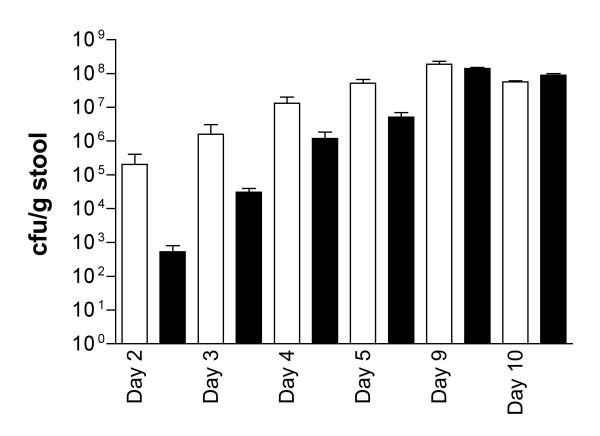
Gastrointestinal colonization of mice with the wild-type (white bars) or the biofilm-negative transposon mutant 10D5 (black bars). Colonization of mice with the transposon mutant was delayed with about 5–10 times reduced colony counts during the first 5 days of the experiment. After that the colony counts were comparable to the wild-type strain.